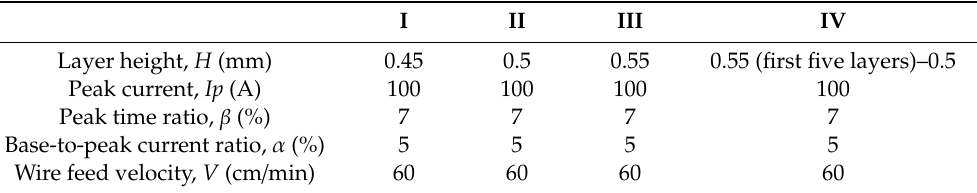
Table 3. Four groups of di ff erent layer height.